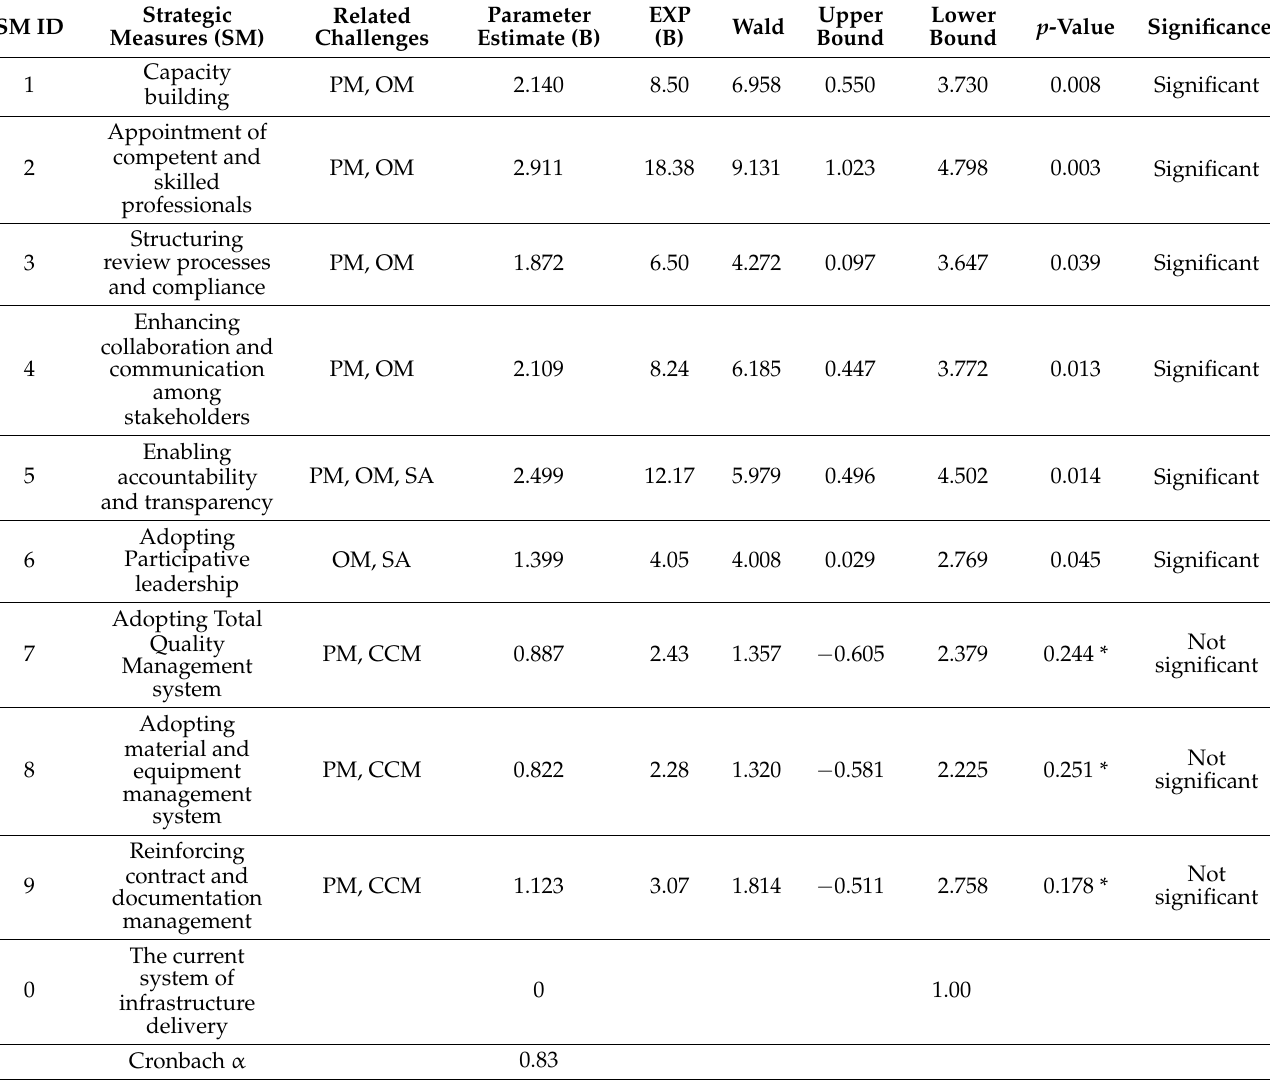
Table 6. Strategic measures and system thinking framework to efficient project